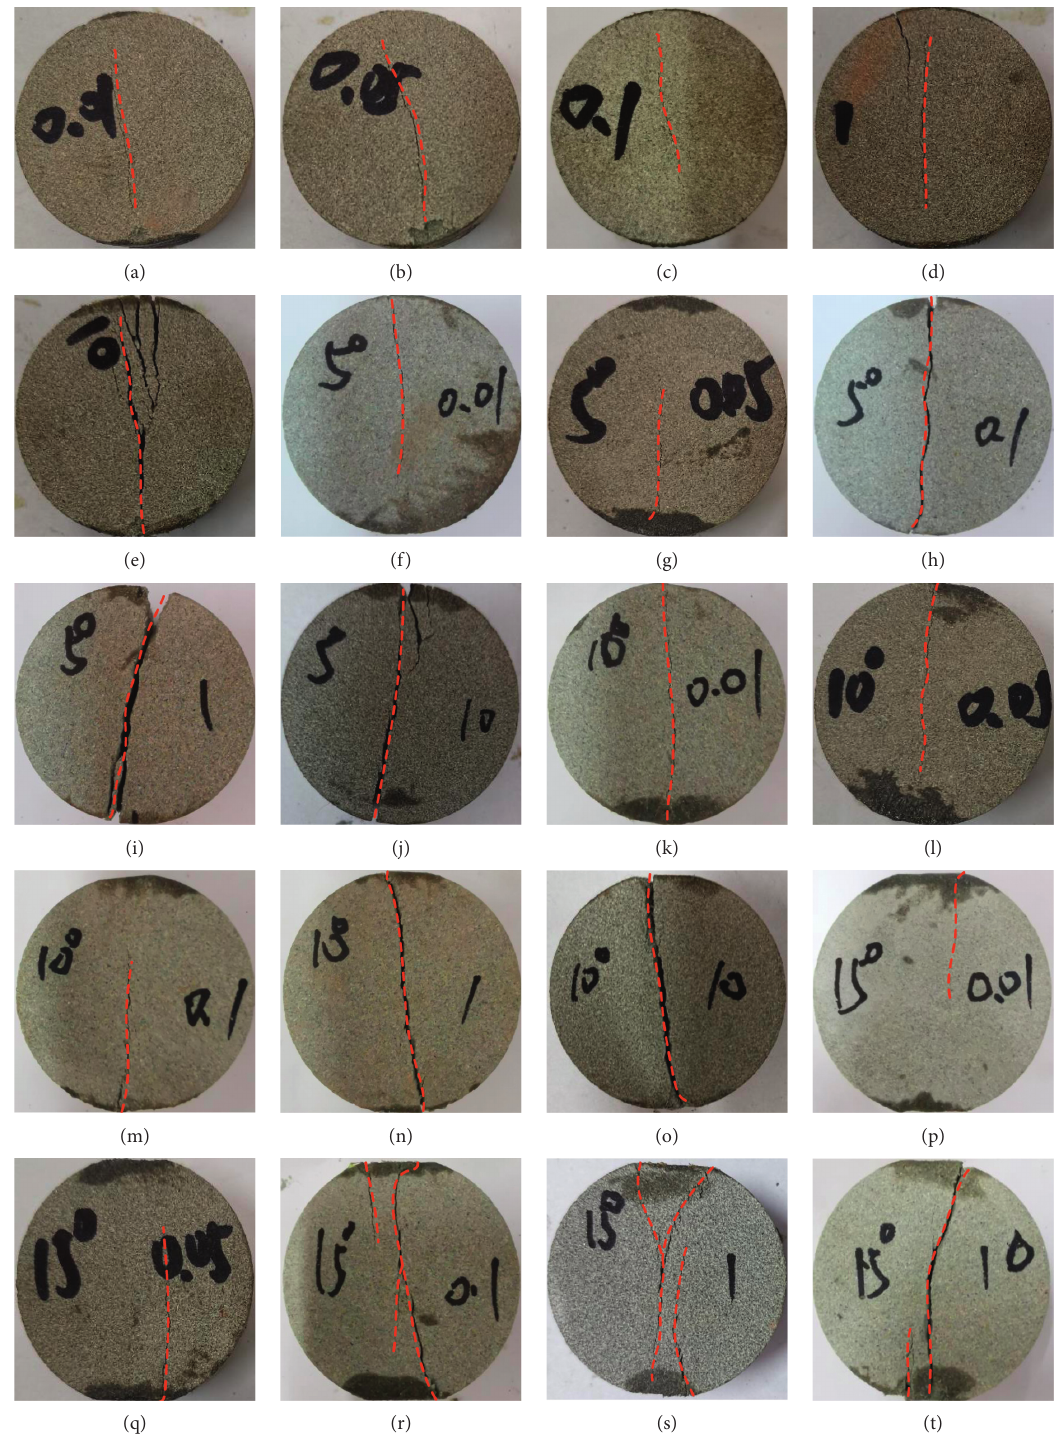
Figure 4: Typical failures after indirect tests: (a–e) rock failures at the loading rates of 0.01, 0.05, 0.1, 1, and 10mm/min, respectively, for the BT tests; (f–j), (k–o), and (p–t) FBT tests with the loading angles of 5 ° , 10 ° , and 15 ° ,